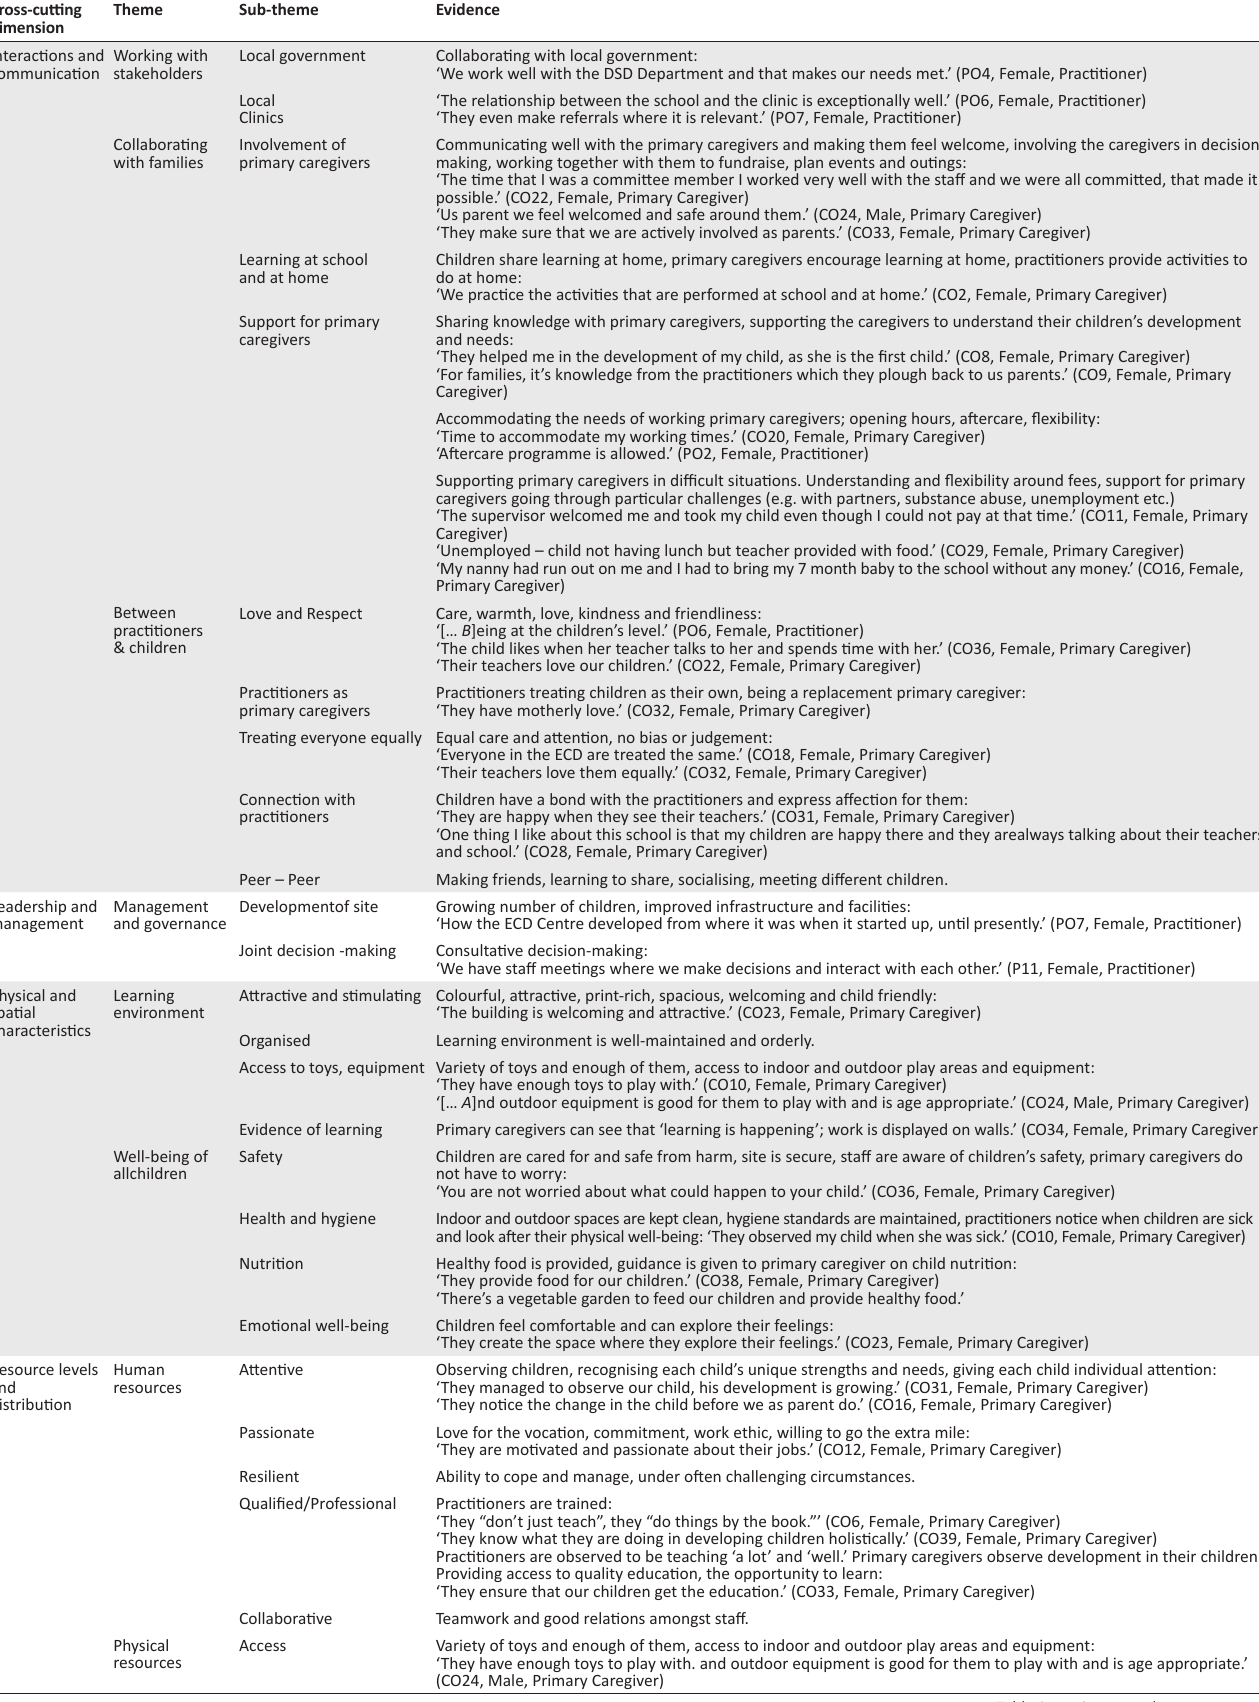
TABLE 2: Data analysis What is quality early childhood development? (Data from primary caregivers and practitioners) Cross-cutting dimension